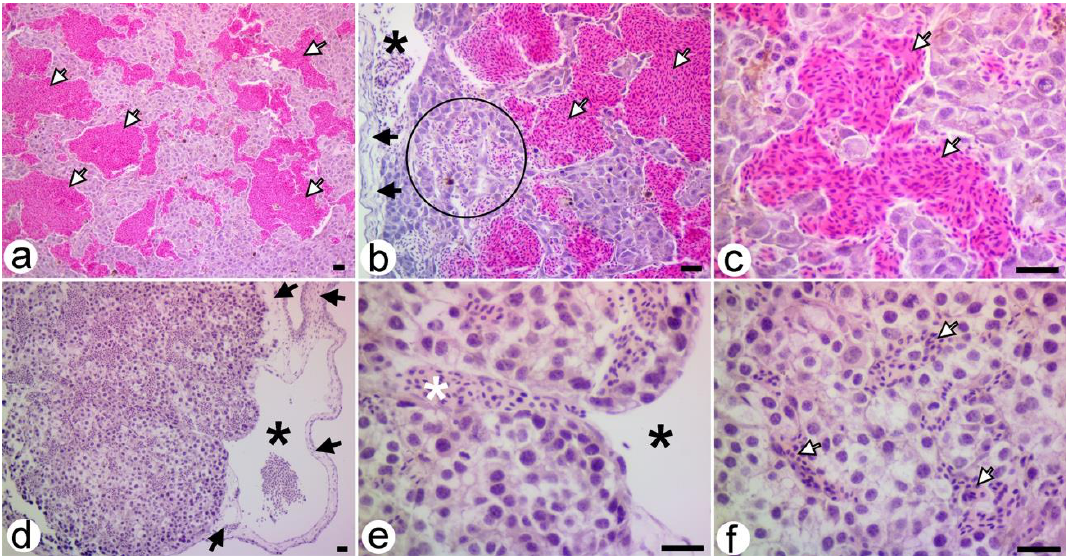
Figure 3. Histopathology of the five-day-old untreated B16F10 xenograft ( a–c ), and the local metastasis ( d–f ). Tumor areas with blood infiltrate (circle area) interposed between CAM vessels (black stars) and intratumoral cavernous vascular spaces filled with nucleated erythrocytes (white arrows). In the local metastases, a CAM vessel (white star) entering between the tumor cavernous vascular spaces can be observed. Black arrows show CAMs located underneath xenografts. Hematoxylin and Eosin staining. Bar = 25 µm.